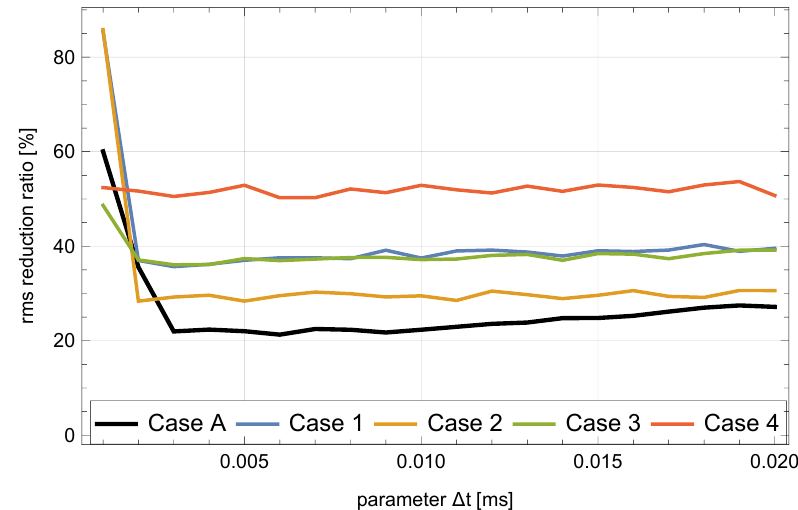
Figure 10. Dependence of the rms reduction ratio on the parameter ∆ t for κ = 0.03 in all control cases. Mean values were computed for 108 different random seismic